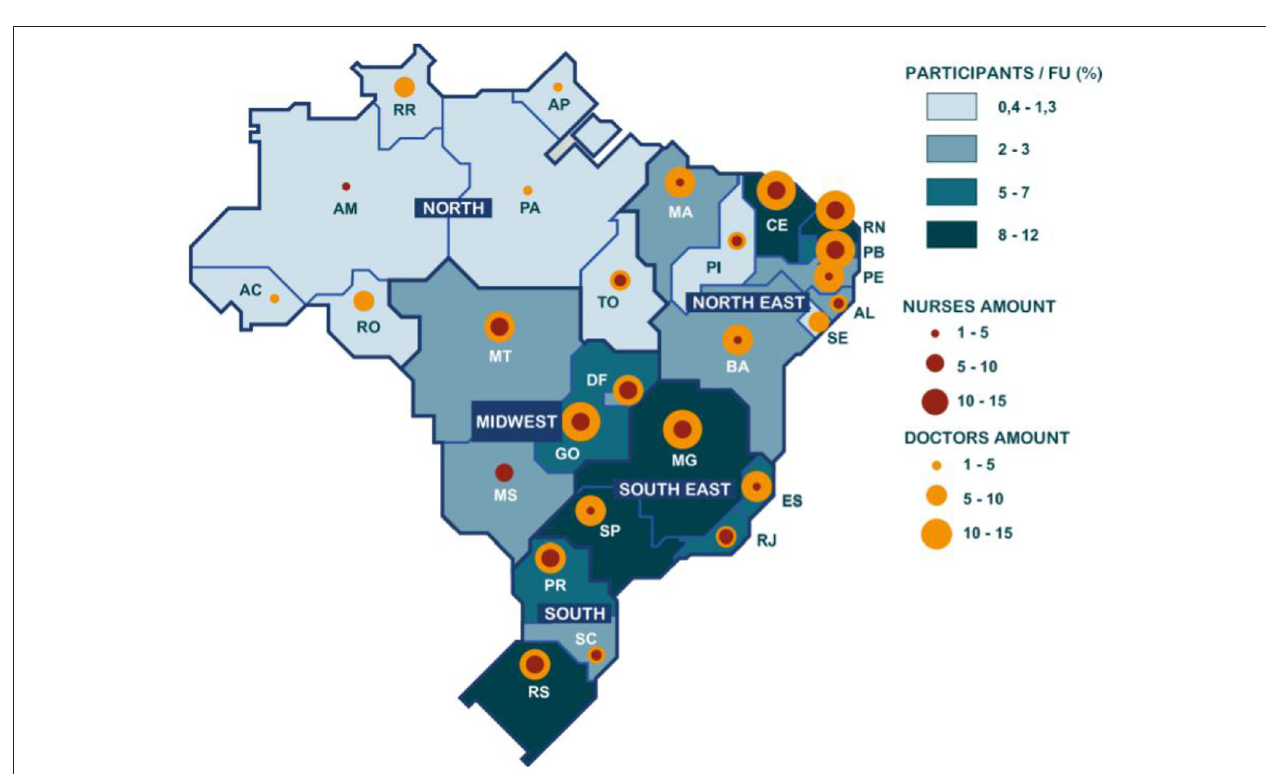
FIGURE 5 | Sharing learning on